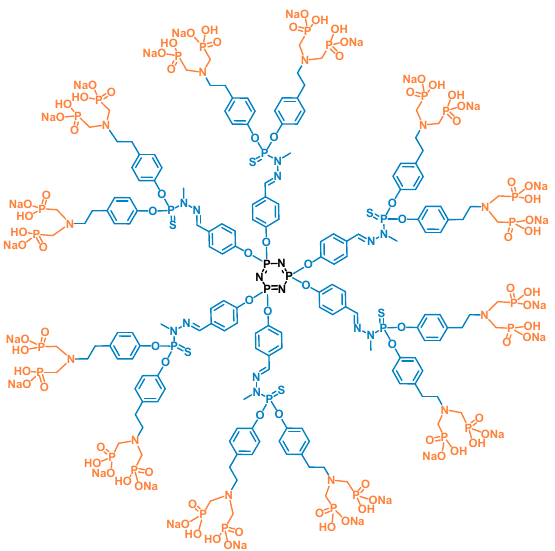
Figure 1. Two-dimensional structure of the azabisphosphonate (ABP) dendrimer. The cyclotriphosphazene core (N 3 P 3 ) is in black, and the poly(phosphorhydrazone) (PPH) branched monomers (including the point of divergence) are in blue. The tyramine-based (in blue) ABP surface groups are in orange.